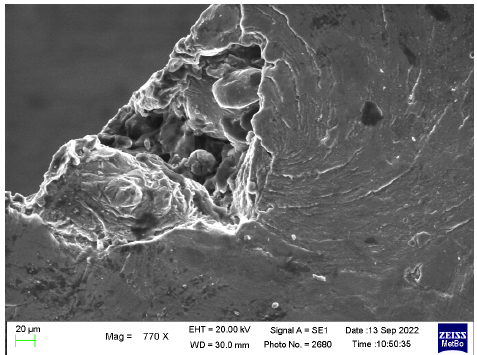
Figure 7. Fatigue crack origin on the surface of a shot-peened specimen.